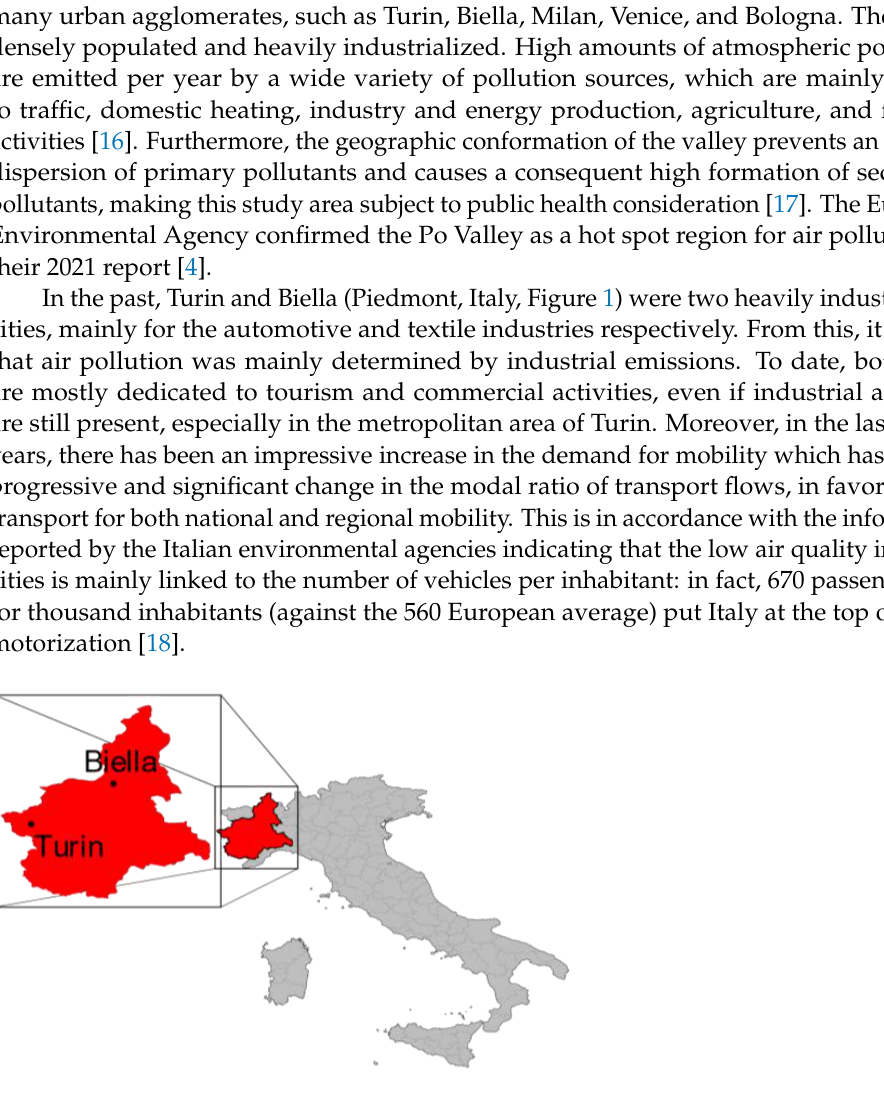
Figure 1. Map of Italy. In the magnifying lens is reported the region Piedmont with the geographical position of the cities of Turin and Biella.